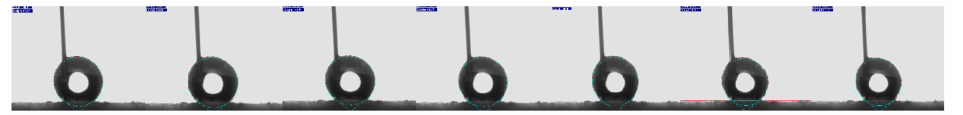
Figure 7. The contact angle decreased to the receding contact angle measured on the travertine stone coated with octyl-modified silica nanostructured film.